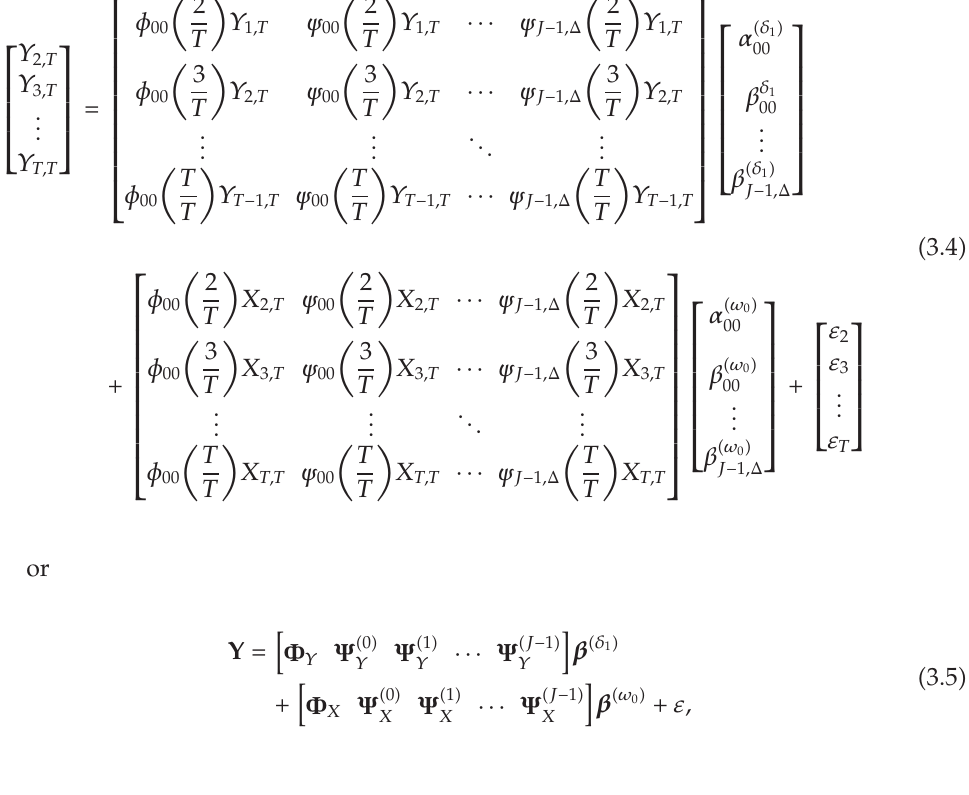
(cid:5) · (cid:6) , (cid:5) d (cid:6) (cid:5) δ (cid:5) f (cid:6) (cid:5) w (cid:5) · (cid:6) 1 2 , 0